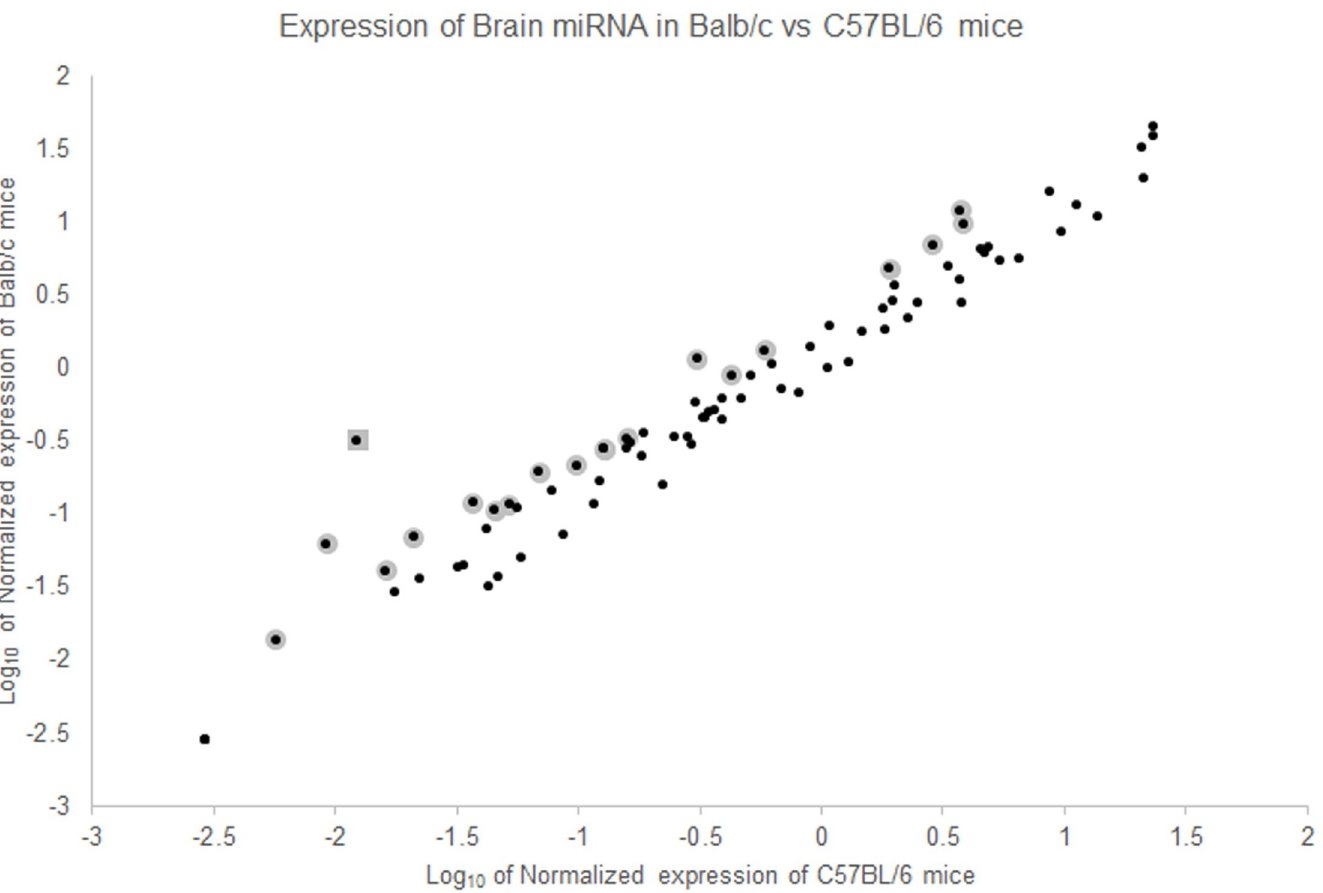
Fig 1. Balb/c and C57BL/6 mice express some brain miRNAs differently. When 84 miRNAs were tested using a PCR array, many miRNAs are expressed similarly in both strains of mice. However, some genes show differences expression in Balb/c as compared to C57BL/6 mice. Those with greater than 2-fold difference in expression are highlighted in grey. mmu-mir-652-3p is marked with a square (see below).